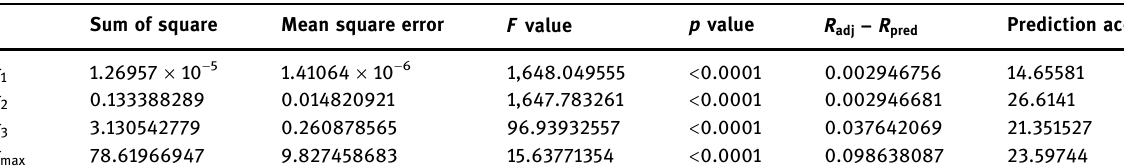
Table 5: Overall parameter levels of the model